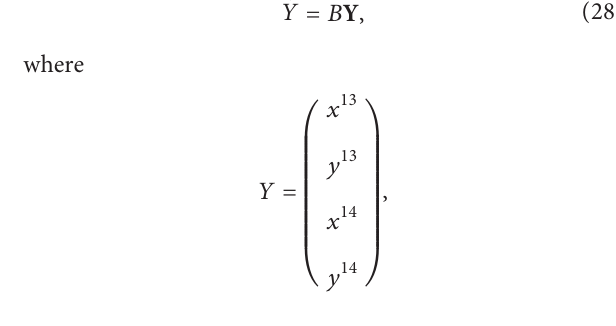
Figure 4: Locations of all equilibrium points for three values of β (0.4 (cyan), 0.9 (red), and 1.4 (black)).